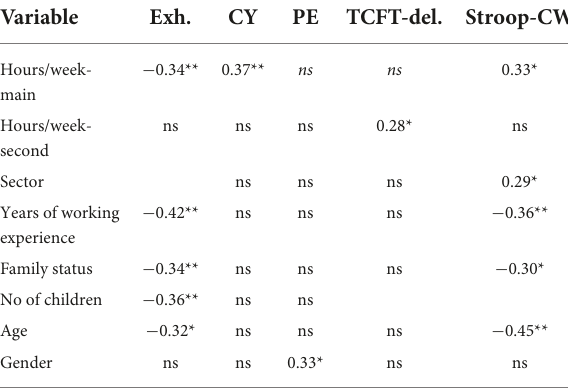
TABLE 2 Correlations of demographics (T1) with MBI-GS (T3) and cognitive tasks (T3) ( N = 104). Variable